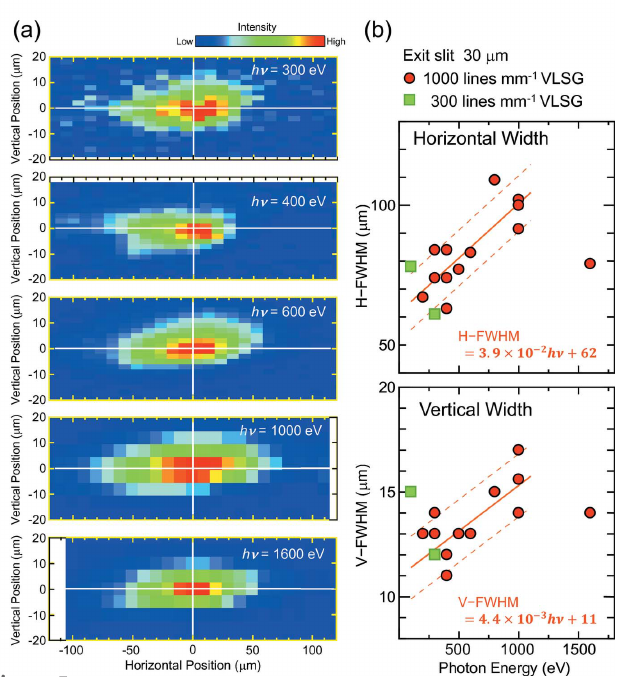
Figure 5 ( a ) Photon energy dependence of the beam profile of the horizontal linear polarized light (1000 lines mm (cid:2) 1 VLSG and exit-slit width of 30 m m). The beam profiles correspond to the image seen from the upstream side. ( b ) Plots of FWHMs of beam spots in the vertical and horizontal directions against photon energy. The FWHMs of beam spots using the 300 and 1000 lines mm (cid:2) 1 VLSGs are shown by squares and circles, respectively. Solid linear lines are results of the least-squares fitting of the circles between 200 and 1000 eV with the 1000 lines mm (cid:2) 1 VLSG, and dashed lines correspond to lines shifted by (cid:6) 10 m m (horizontal) and (cid:6) 1.5 m m (vertical).